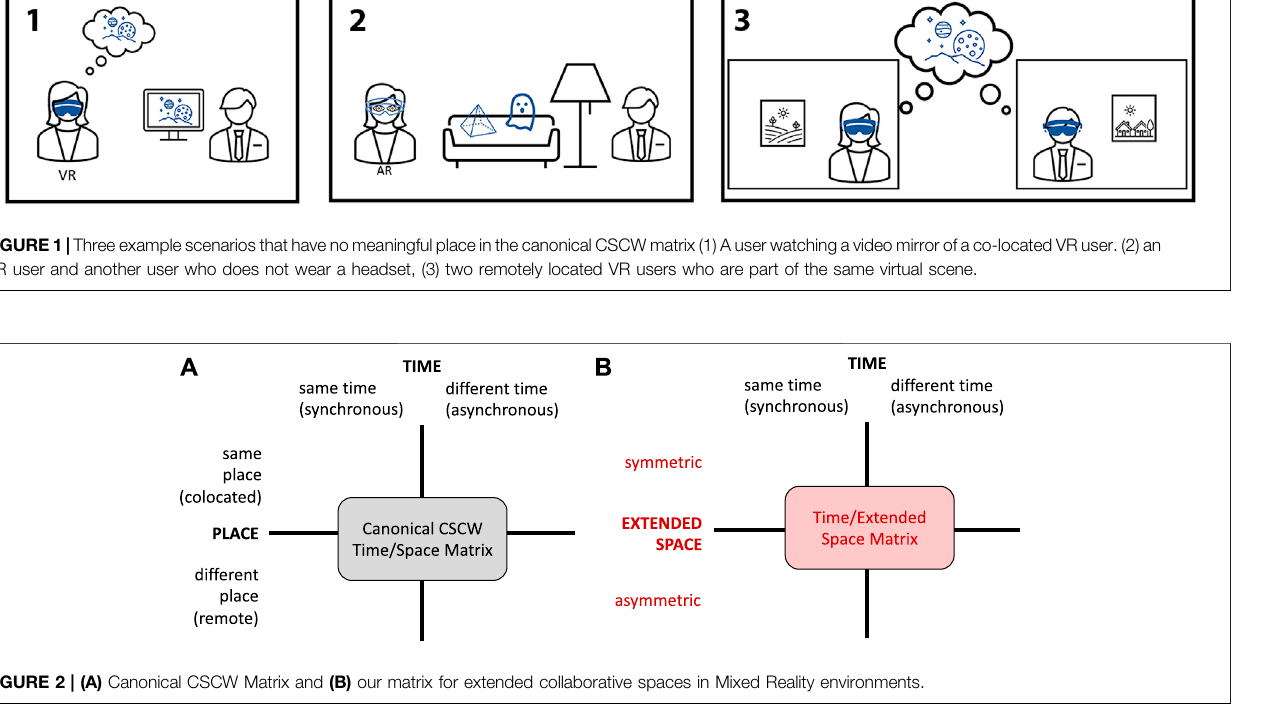
Frontiers in Virtual Reality |